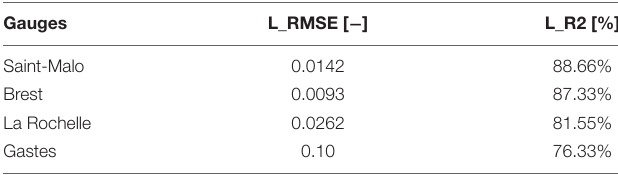
TABLE 5 | Summary of meta-model evaluations using cross-validation technique (mean values).